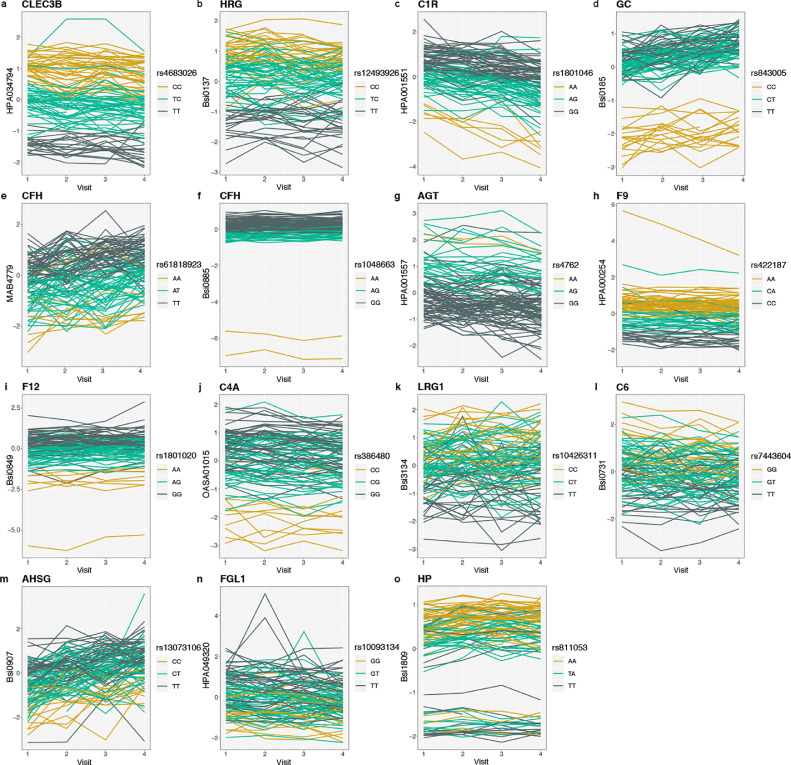
Longitudinal characteristics of plasma protein genotypes. The line plots show plasma proteins associated to genetic variants where z-scores were used to represent protein levels. Each line represented one individual and colour codes the genotypes. Only individuals with data from all four visits were included for visualization.